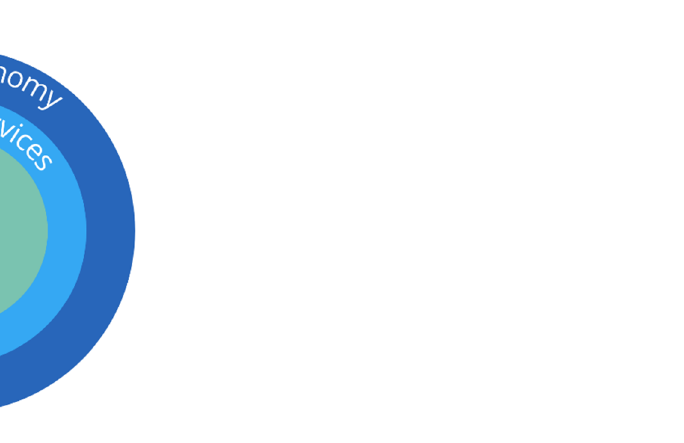
Figure 1. Structure of Mobility as a Service in the context of mobility services and digital economy.